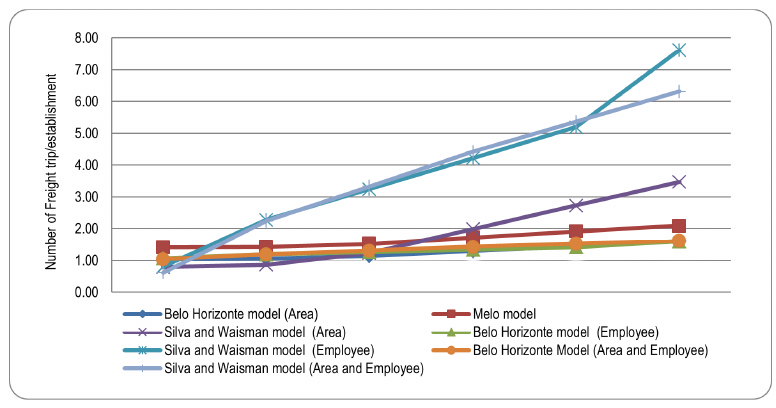
Figure 4: Comparison of models considering area (left) employers (center) and area and employees